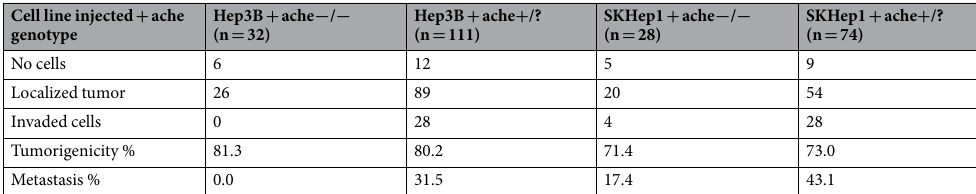
Table 1. Tumorigenesis and Metastasis Percentages. Liver cancer cell lines xenografted into ache mutant and siblings at 2 dpf, analyzed at 3